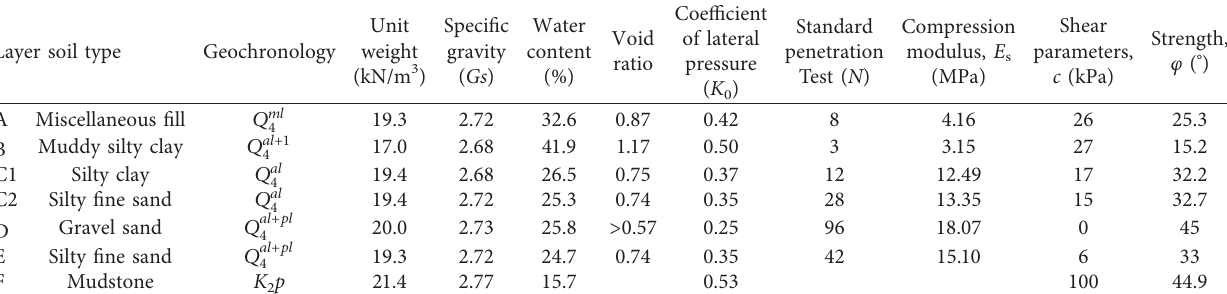
Table 1: Geotechnical properties of the soil.